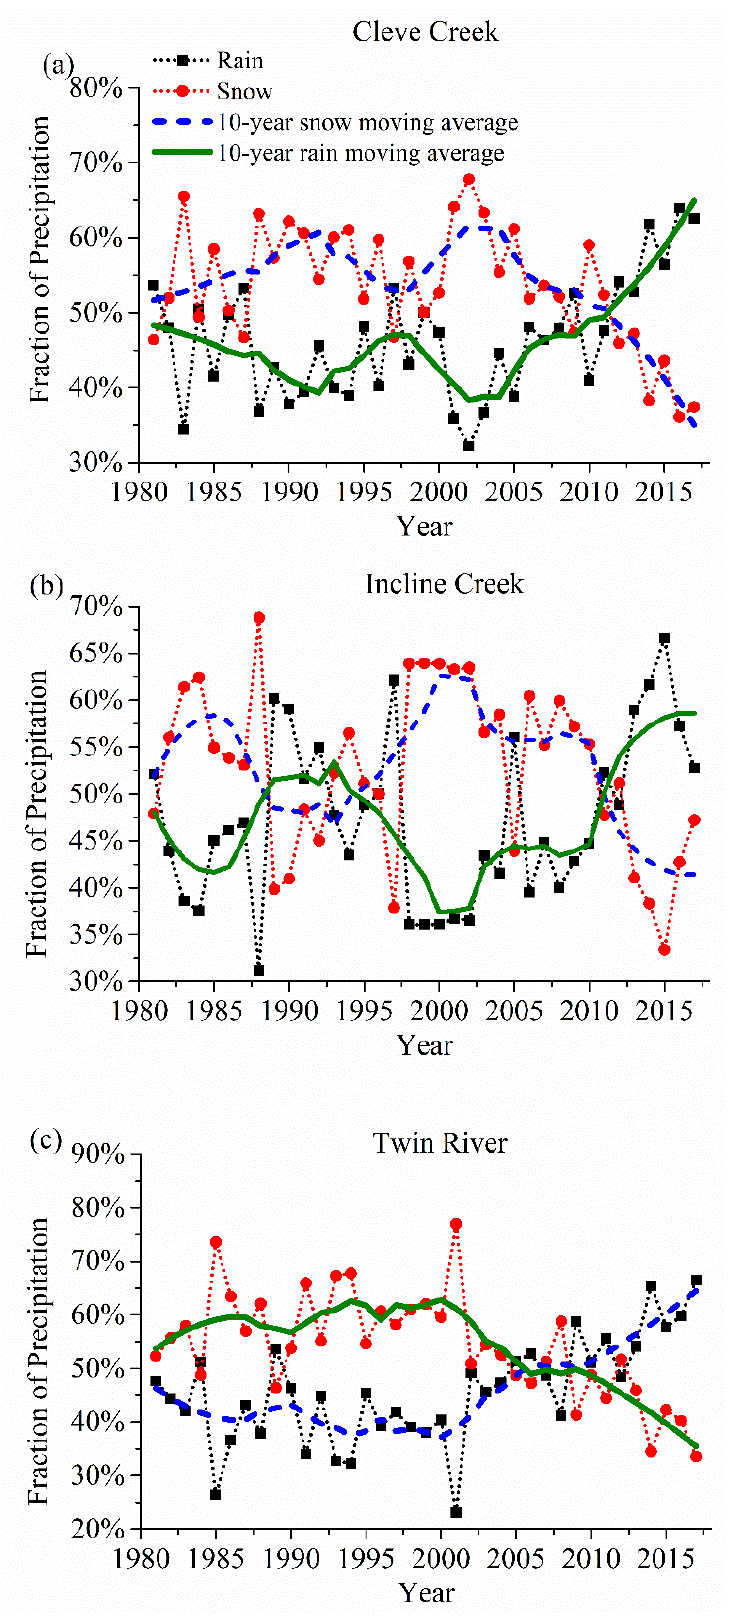
Figure 3. Snow fraction in precipitation in ( a ) Cleve Creek, ( b ) Incline Creek, and ( c ) Twin River watershed decreases as temperature increases during the recent 37 years.